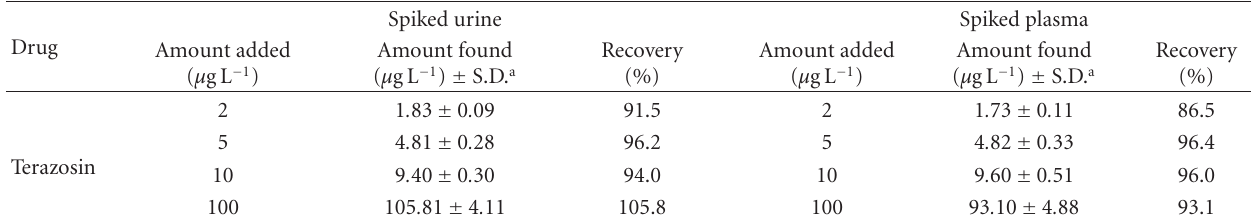
Table 3: Determination of terazosin in spiked urine and spiked plasma by present work.